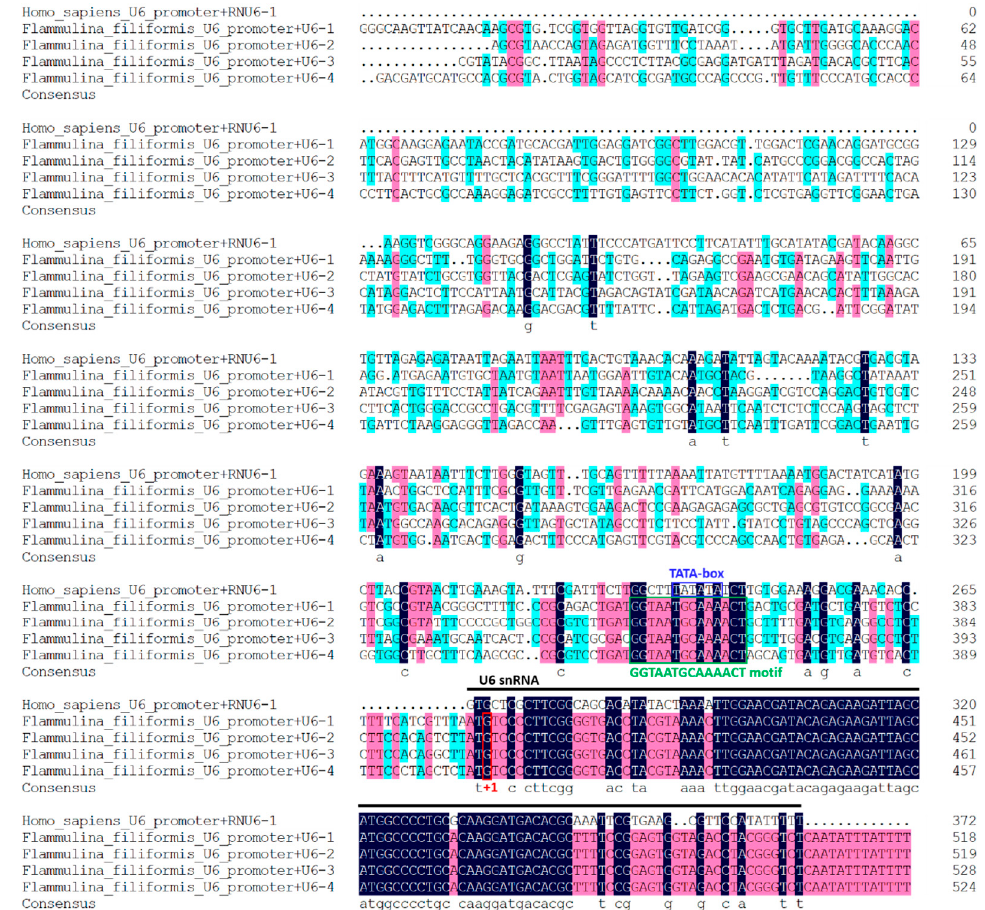
Figure 2. Analysis of F. filiformis U6 and promoter sequences. Multiple alignments of F. filiformis and human U6 snRNA are illustrated. Black lines indicate human U6 snRNA sequence. The conserved elements TATA box and “GGTAATGCAAAACT” motif are indicated by blue and green frames, respectively. The nucleotides “G” that could be recognized by FfU6 promoters for transcription initiation (+1) are labeled with a red box. Different colors denote different levels of sequence identity. The strictly conserved nucleotides (100% identity) are highlighted in black, while those with ≥ 75% and ≥ 50% identity are highlighted in red and blue, respectively. The multiple sequence alignments were performed using DNAMAN software.